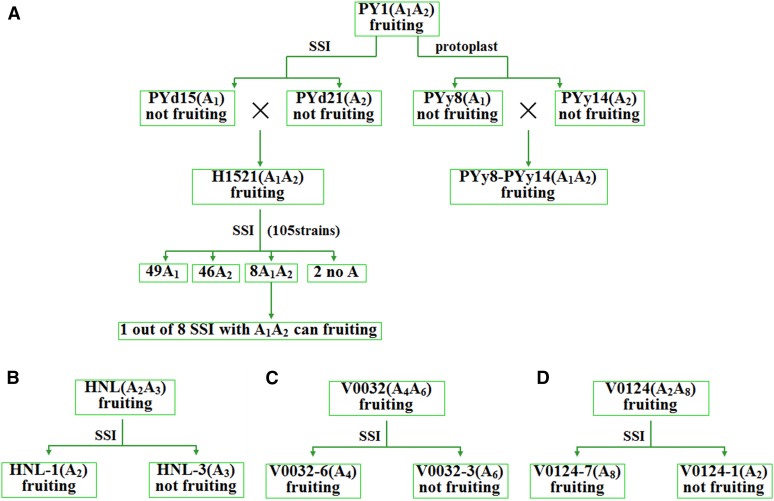
Overview of fruiting assays with heterokaryotic and homokaryotic V. volvacea strains. Mating types are indicated when known, origin of homokaryons (protoplast derived or SSI-based) is indicated by lines connecting with their parental heterokaryons. (A) Fruiting ability of PY1 and PY1 derived homokaryons PYd15, PYd21, PYy8, PYy14, and newly crossed heterokaryons H1521 and PYy8-PYy14. (B–D) Fruiting ability of the V. volvacea wild strains and SSIs whose mating types were analyzed in this study.